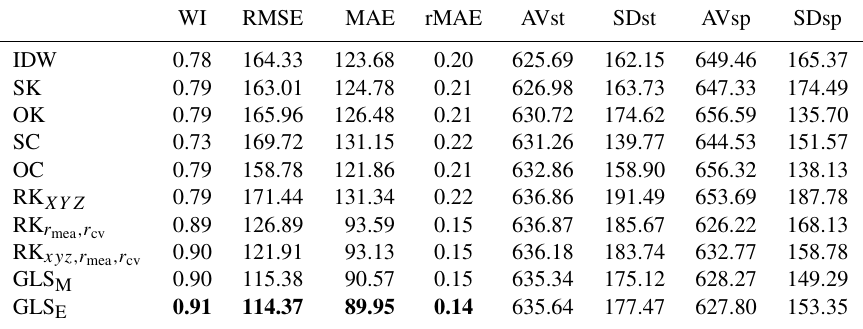
Table 1. Cross-validation indices for the best variants of each spatial interpolation model. AVst – at-site average; SDst – at-site standard deviation; AVsp – spatial average; SDsp – standard deviation of the spatial R factor. The best cross-validation indices are marked in bold font. WI RMSE